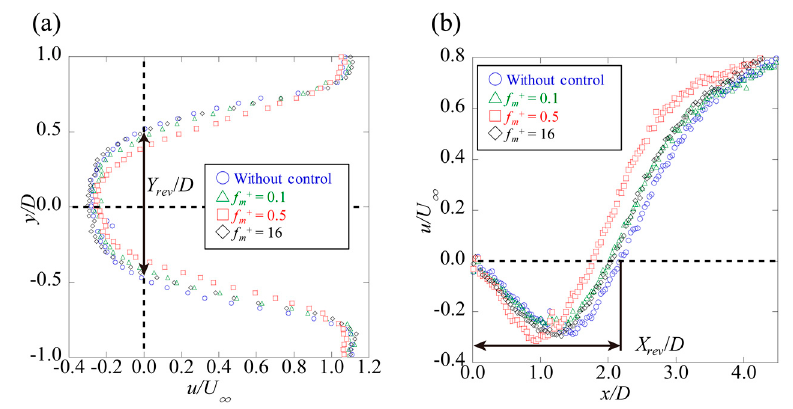
Figure 10. Normalized u profiles in the x - y cross section ( z / D = − 0.5) at ( a ) x / D = 1.25 and ( b ) y / D = 0.0.